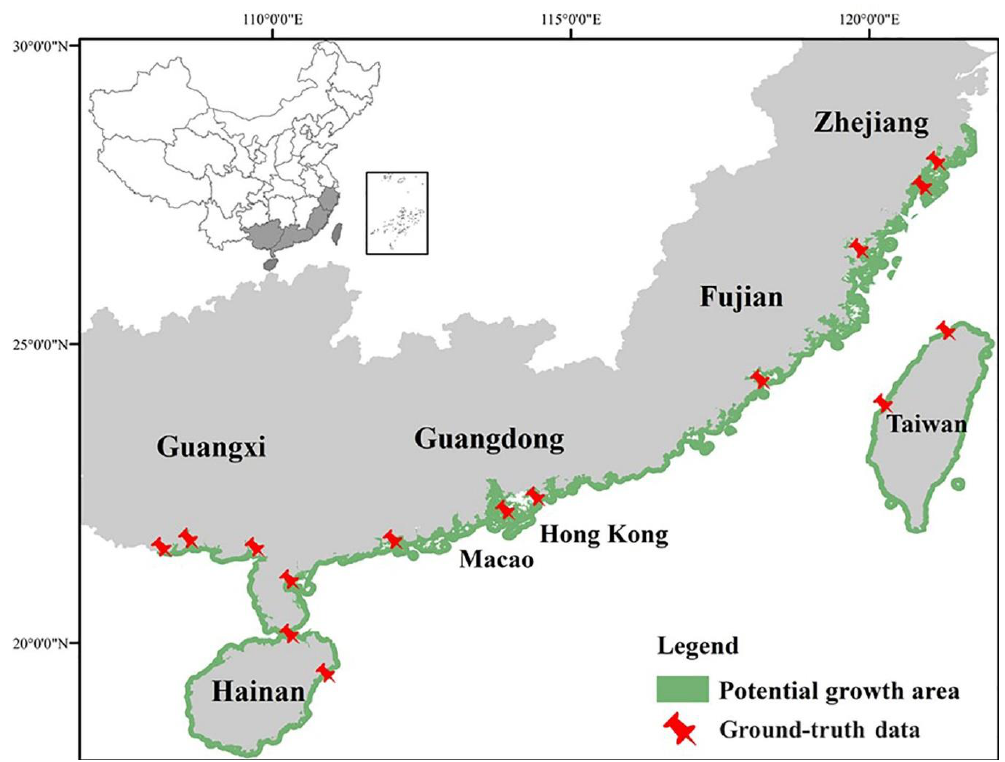
Figure 1. Location of study area and potential mangrove growth area in China.